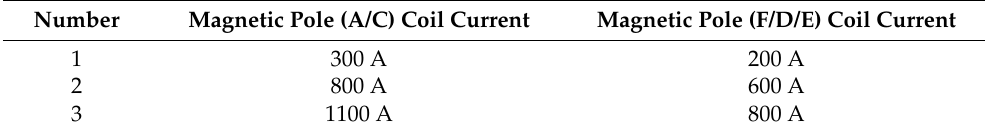
Table 2. Details of the current of each magnetic